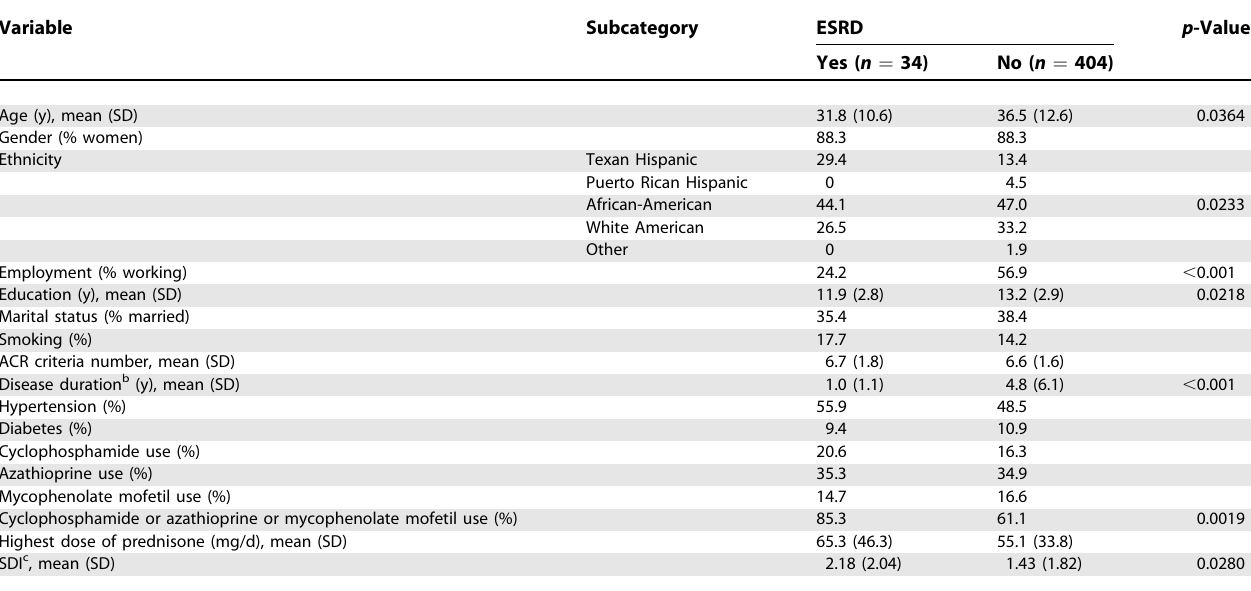
Table 2. Baseline Socioeconomic–Demographic and Clinical Features of PROFILE Patients with Renal Involvement (Incident and Prevalent Cases) as a Function of the Occurrence of ESRD Variable